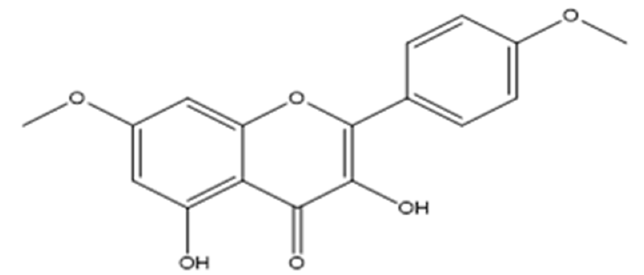
Figure 1. Chemical structure of 3,5-dihydroxy-4 (cid:48)